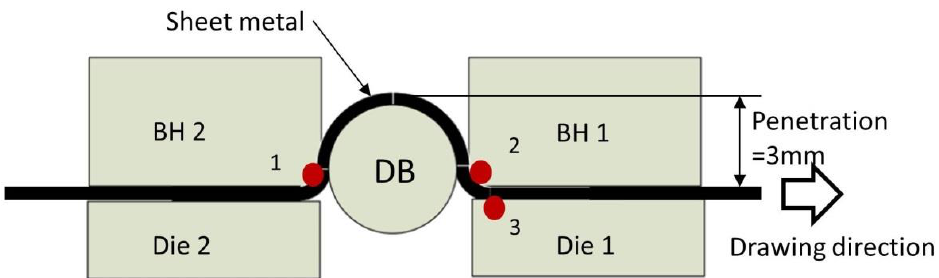
Figure 20. Draw bead geometry for strip drawing tests (BH = blank holder; DB = Draw bead).